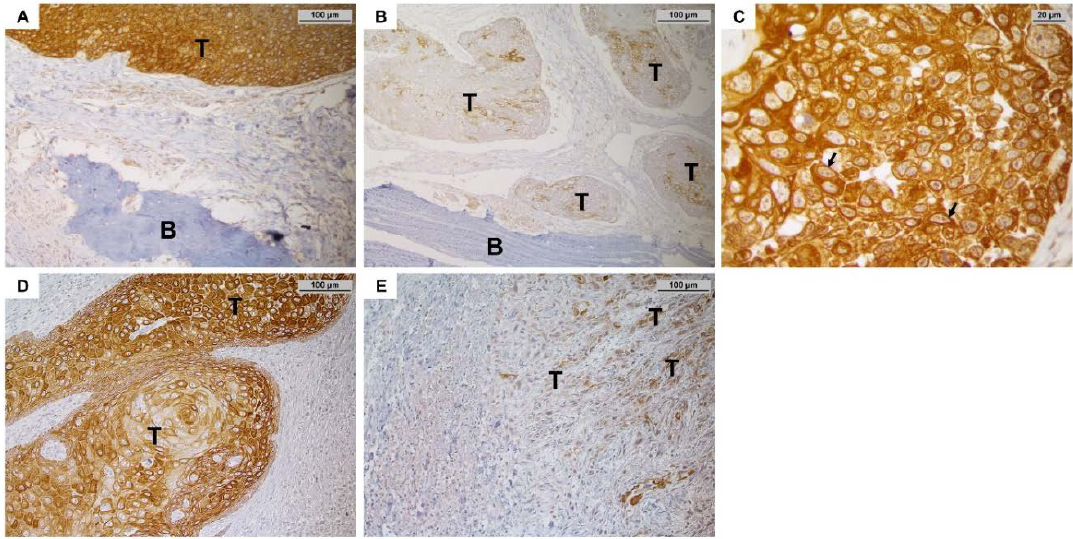
Figure 4. ( A ) Example of a tumor (T) with high MMP-27 expression at the bone-tumor interface (200× magnification). The tumor shows a bulky appearance and was rather distant to the adjacent bone (marked with B). ( B ) Tumor with low expression of MMP-27; the tumor mass is comprised of islets and in close proximity to the bone. ( C ) Surprisingly, the staining signal of MMP-27 was not only limited to the cytoplasm, but also detectable on the cell membrane (600× magnification). MMP-27 is usually confined to the endoplasmic reticulum. ( D , E ) Demonstration of the effect of MMP-27 on tumor morphology (sections without bone tissue). ( D ) This tumor shows high expression of MMP-27; the cells grow adjacent to each other. ( E ) On the other hand, this sample with low expression of MMP-27 shows single cells and clusters detached from the main tumor, which is often referred to as tumor budding. Table 2. Binary logistic regression analysis of IHC markers, WPOI and histopathological grading in relation to T-stage. Significant results are highlighted in bold.